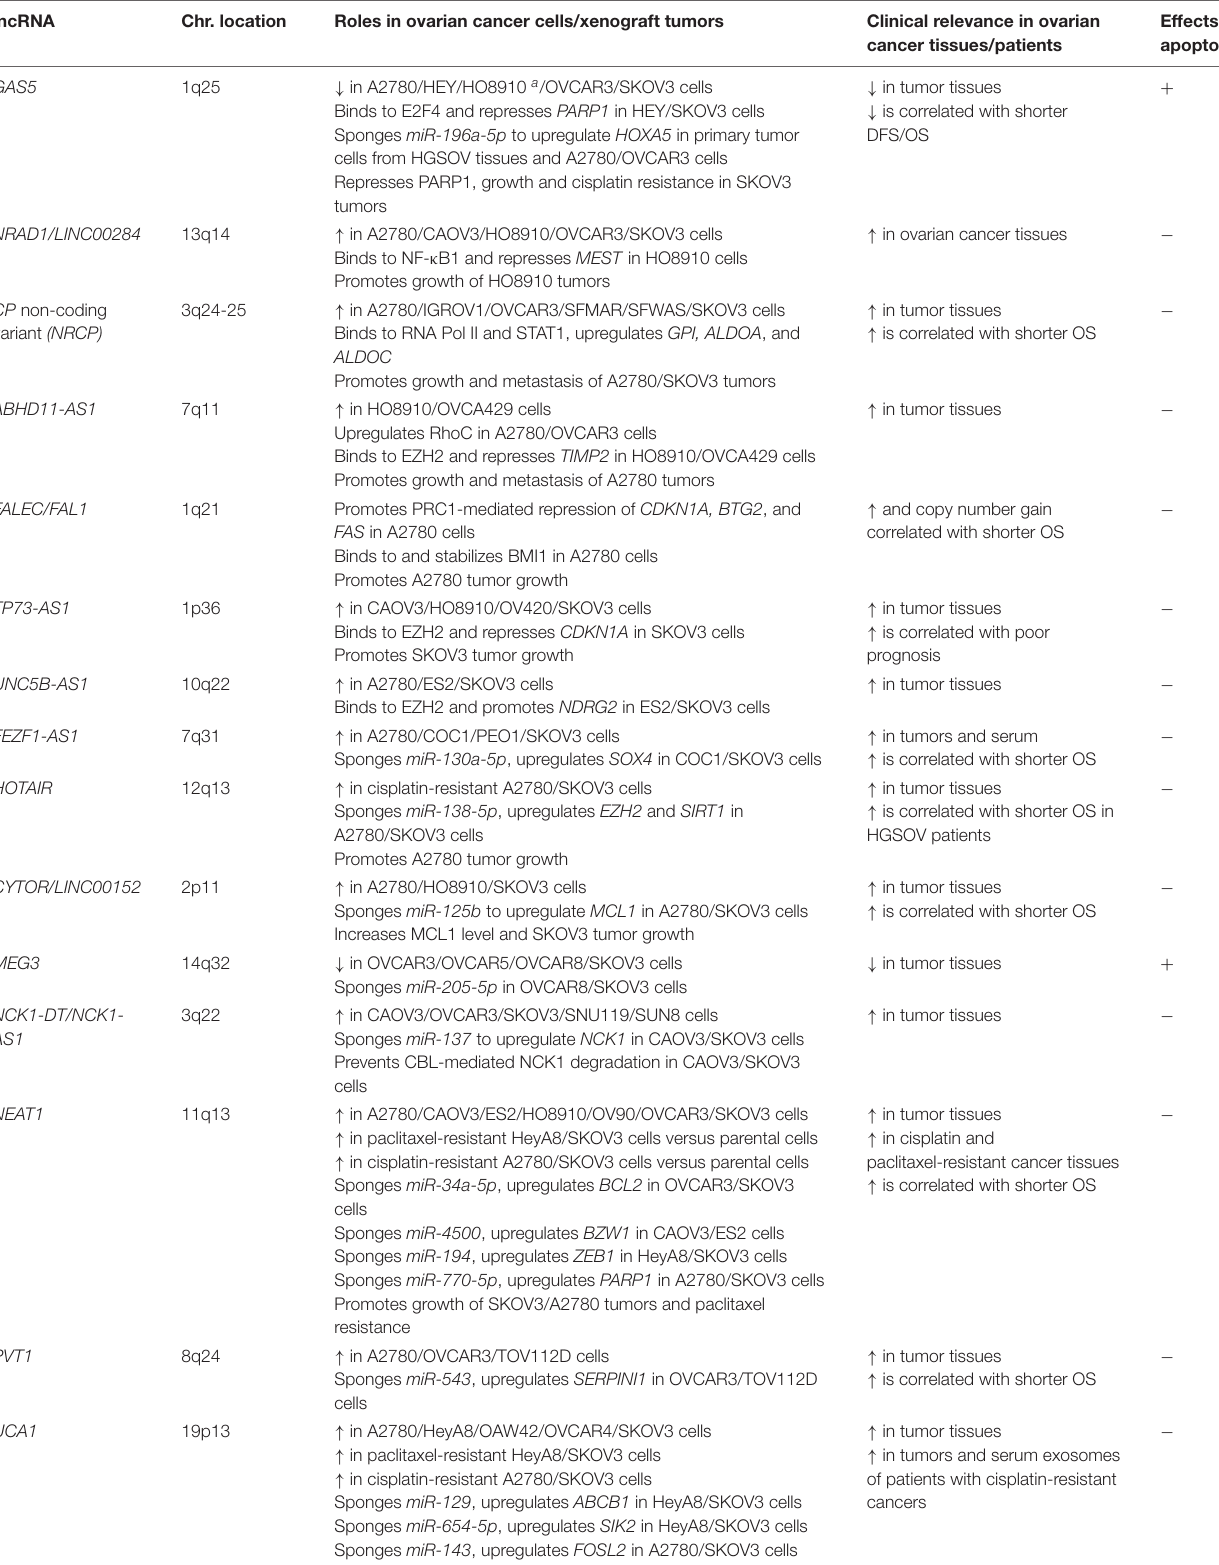
TABLE 1 | Mechanisms of apoptosis-related lncRNAs in ovarian cancer cells. lncRNA Chr. location Roles in ovarian cancer cells/xenograft tumors Clinical relevance in ovarian